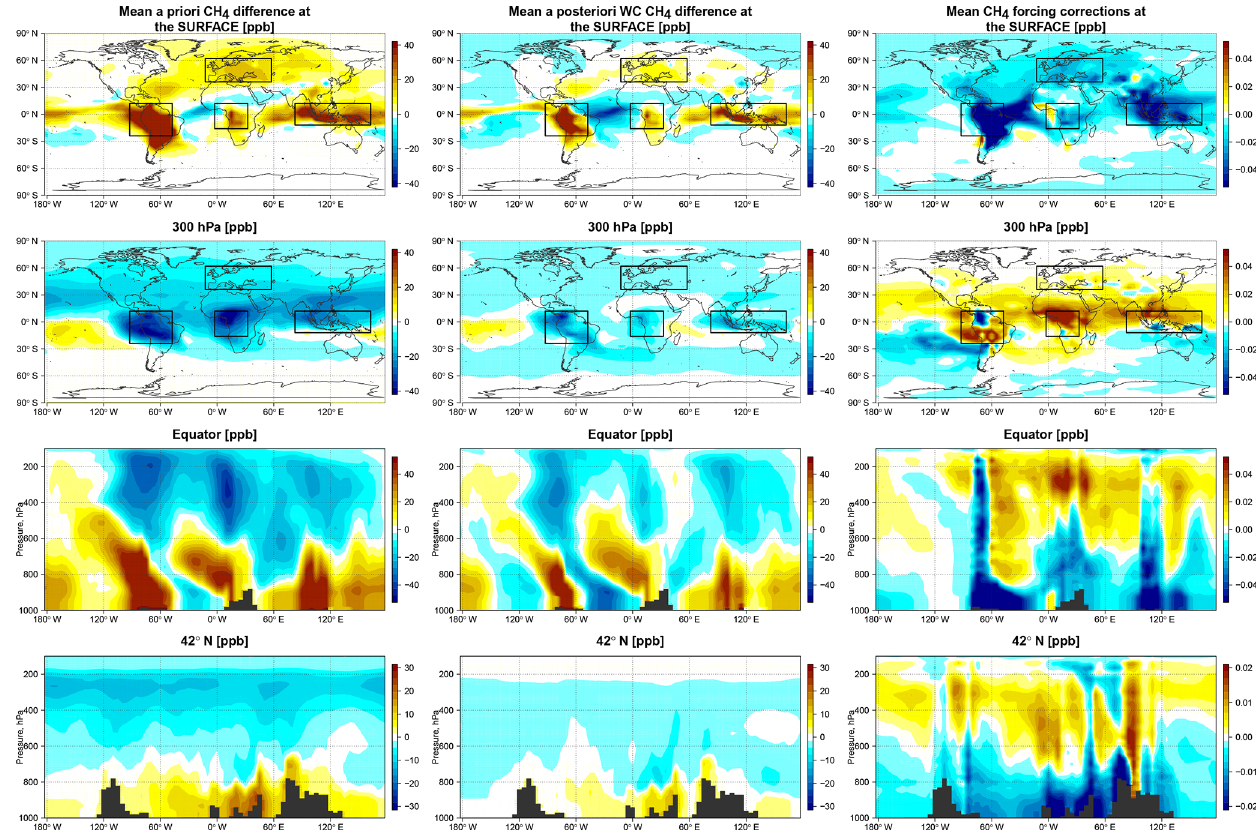
Figure 1. Mean differences in the CH 4 distribution in March 2010 in the OSSE with biased convection. Left column: mean differences between the a priori CH 4 state and the true CH 4 state. Middle column: mean differences between the WC optimized CH 4 state and the true CH 4 state. Right column: the mean WC state corrections (the forcing terms) in parts per billion (ppb). Shown are the latitude–longitude differences at (top row) the surface and (second row) at 300hPa, as well as the altitude–longitude differences (third row) along the Equator and (bottom row) along 42 ◦ N. The black boxes indicate the four domains considered for the regional analysis discussed in the text and shown in Fig.